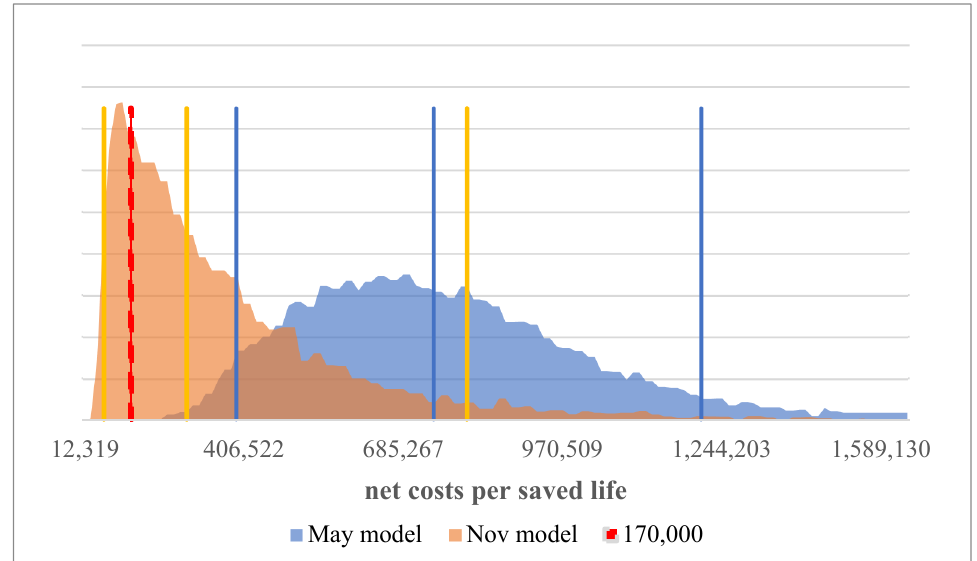
Figure 5. Saved life years incl. unreported cases at the end of the analyzed period.